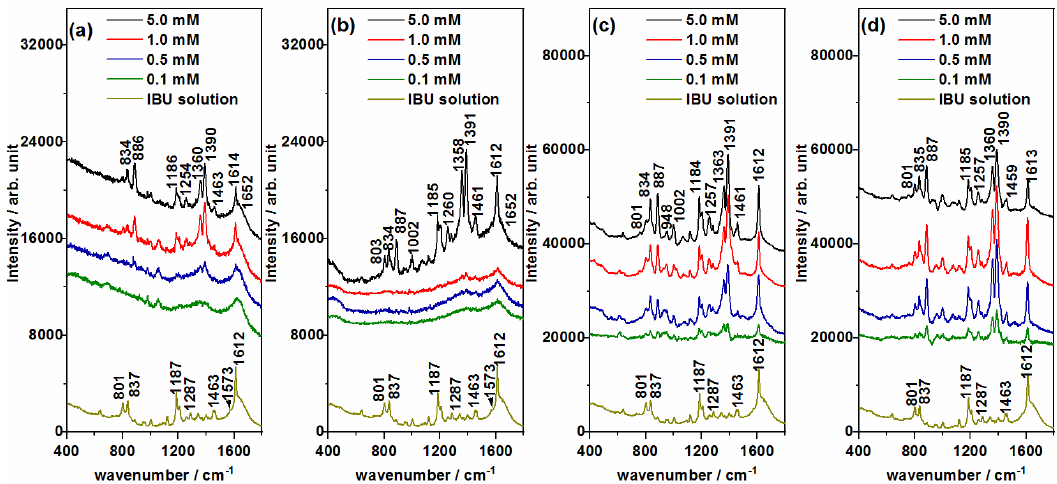
ff erent concentrations using ( a )